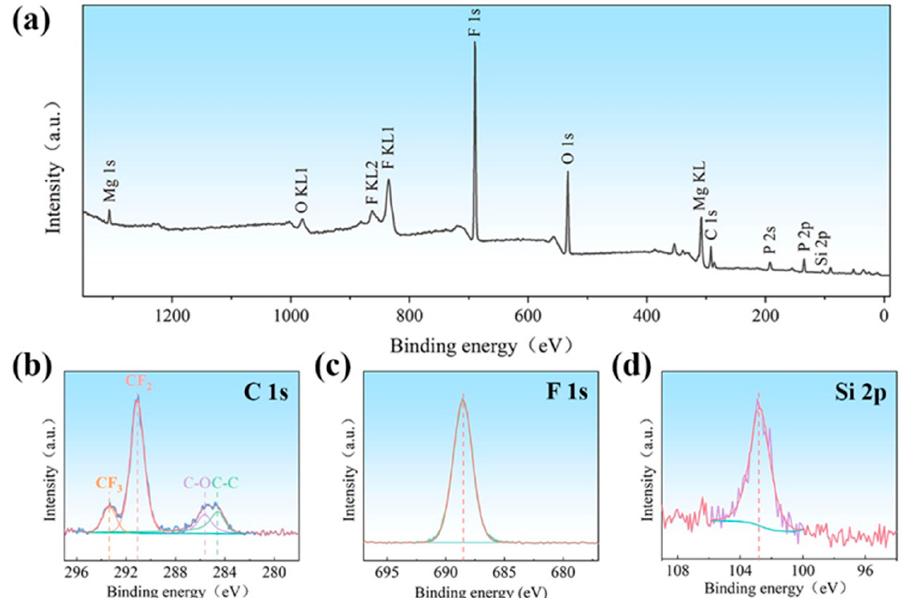
Figure 5. XPS spectra of the PFDS-modified surface: ( a ) survey spectrum and high-resolution spectra of ( b ) C 1s, ( c ) F 1s and ( d ) Si 2p.